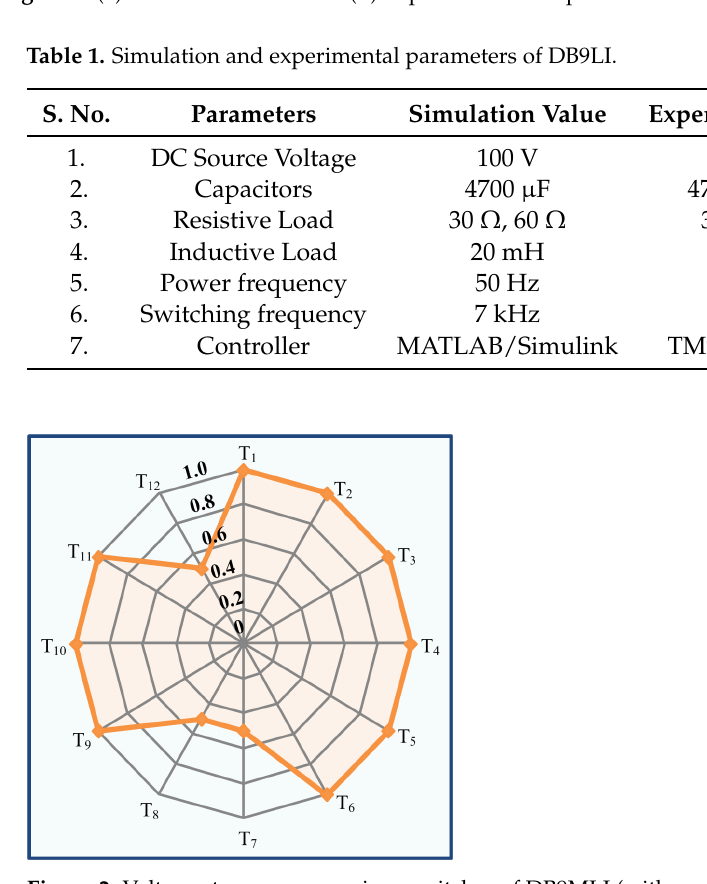
Figure 2. Voltage stress across various switches of DB9MLI (with respect to V in